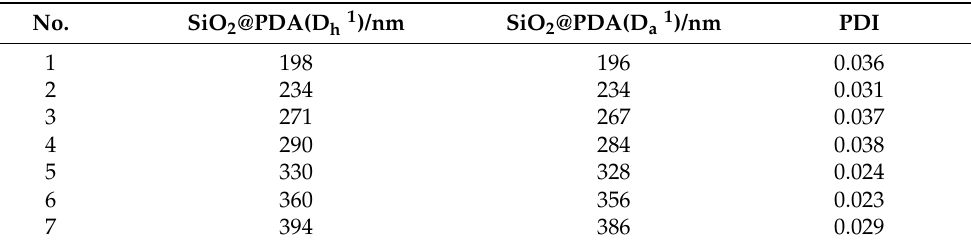
Table 1. Sample diameter size and PDI values.